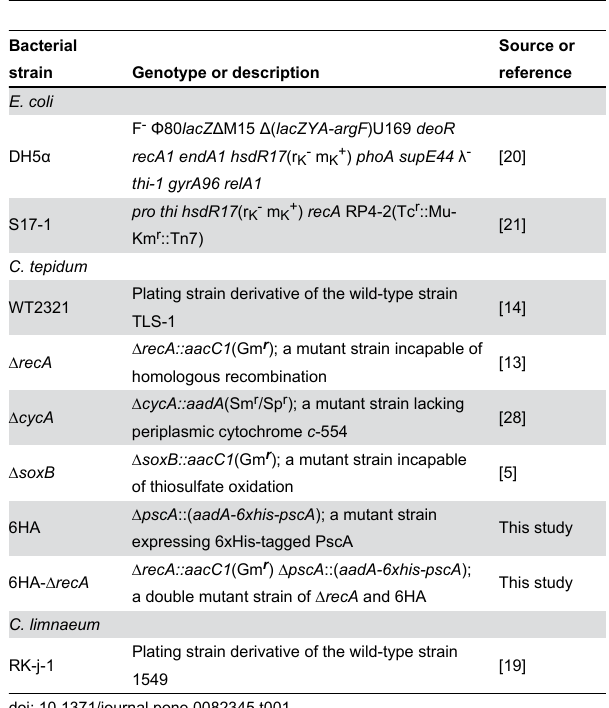
Table 1. Bacterial strains used in this study.